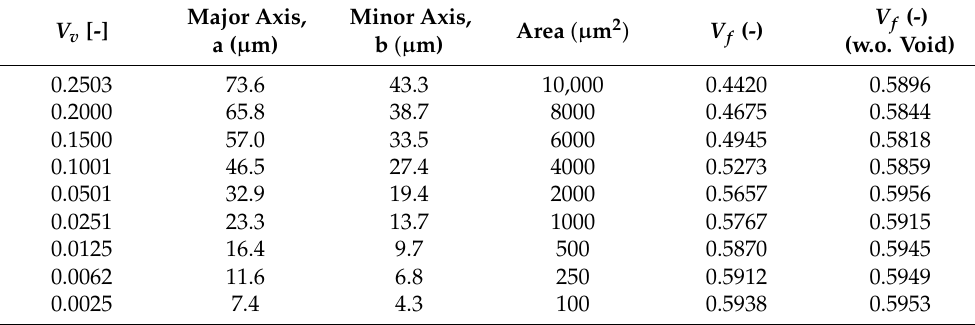
Table 3. V v of the RVEs with an elliptical void angled 0 ◦ and the resulting V f .